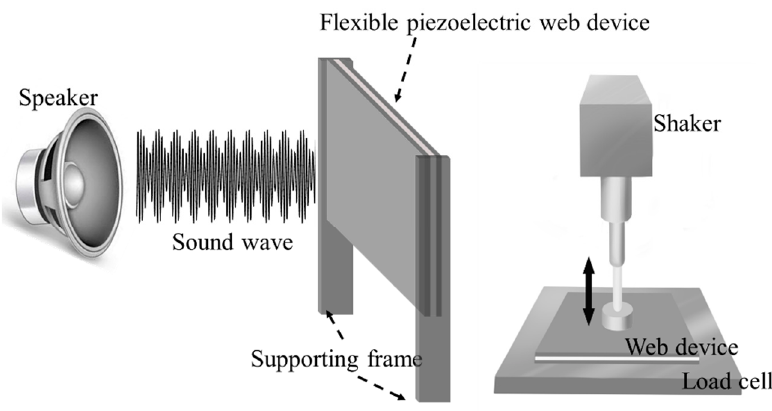
Figure 1. Schematic illustration of the piezoelectric setup for sound waves and mechanical forces.